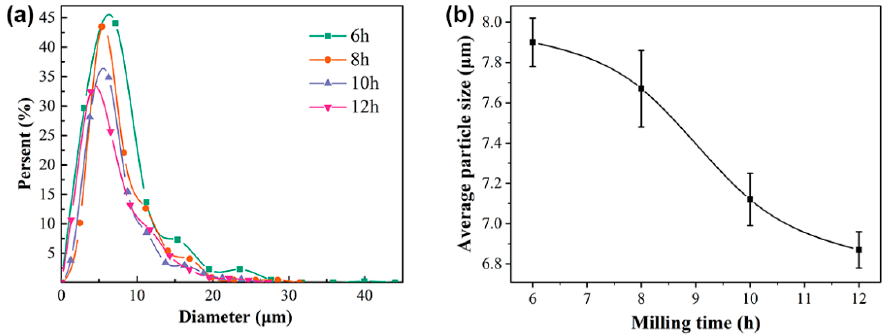
Figure 4. Particle size of Fe 73.2 Si 16.2 B 6.6 Nb 3 Cu 1 nanocrystalline alloy powder: ( a ) particle size distri ‐ bution; ( b ) change in average particle size as a function of milling time.